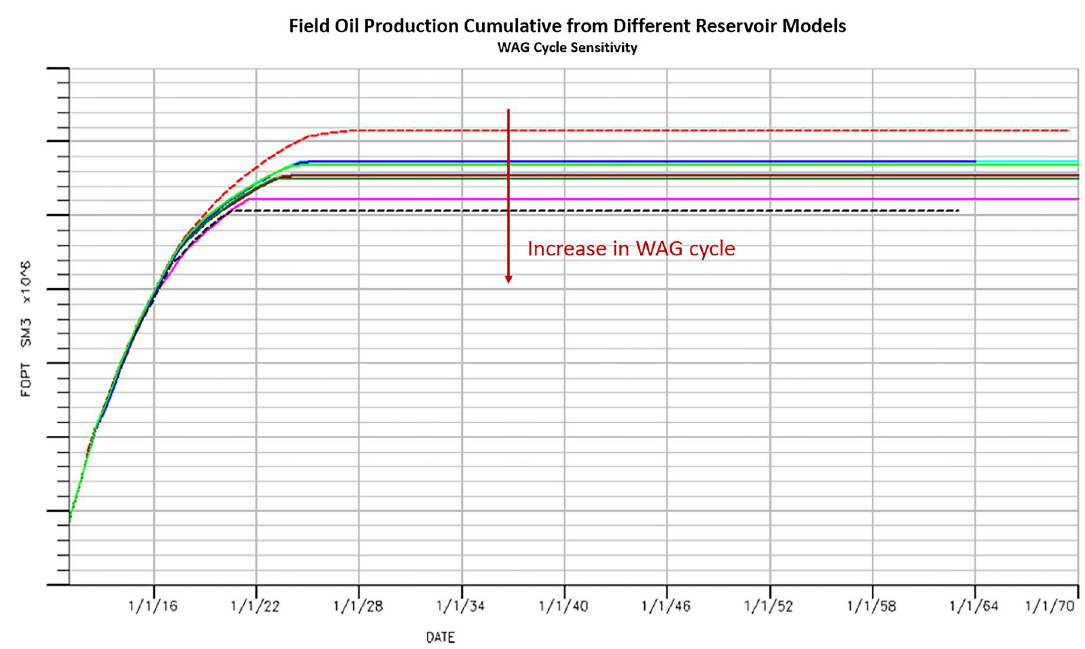
Fig. 6 Impact of WAG cycle length on WAG recovery factor